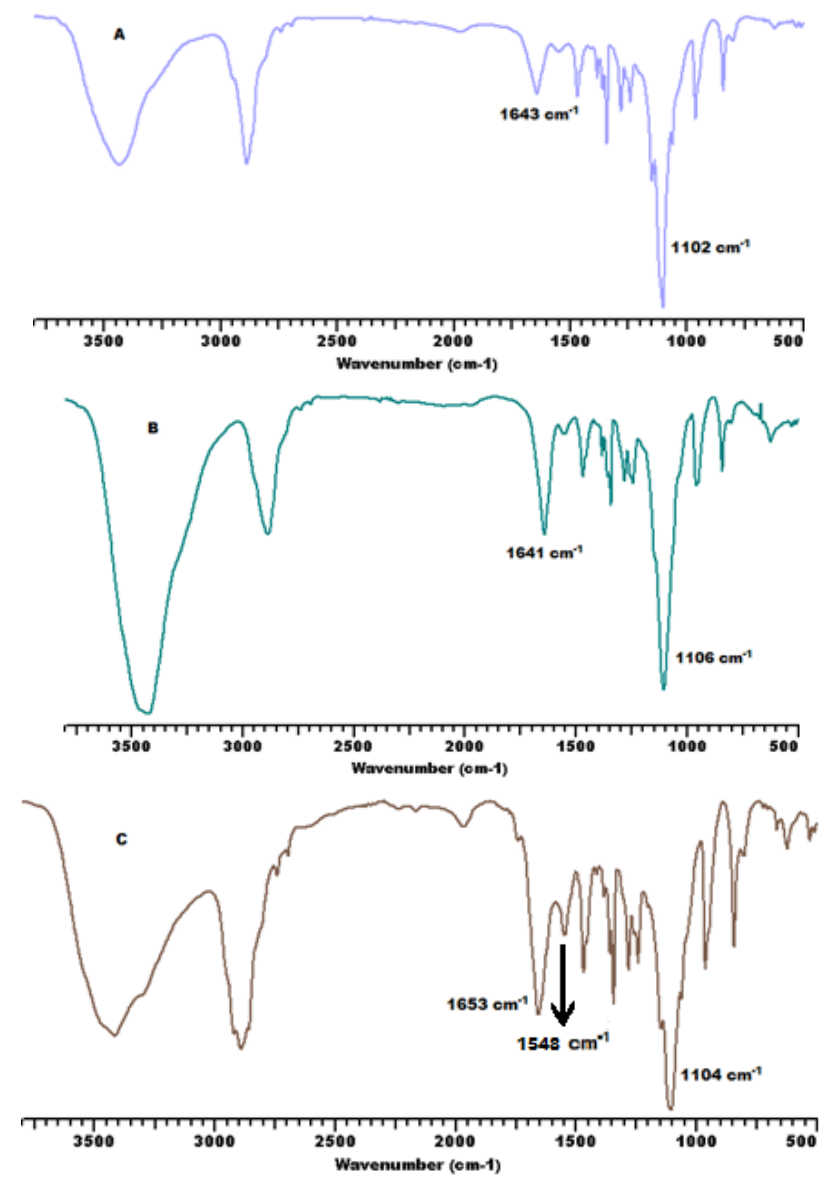
Figure 2. FT-IR spectra of m -PEO- b -poly(His- co -Ala) with ( A ) 10% alanine to histidine molar ratio ( B )